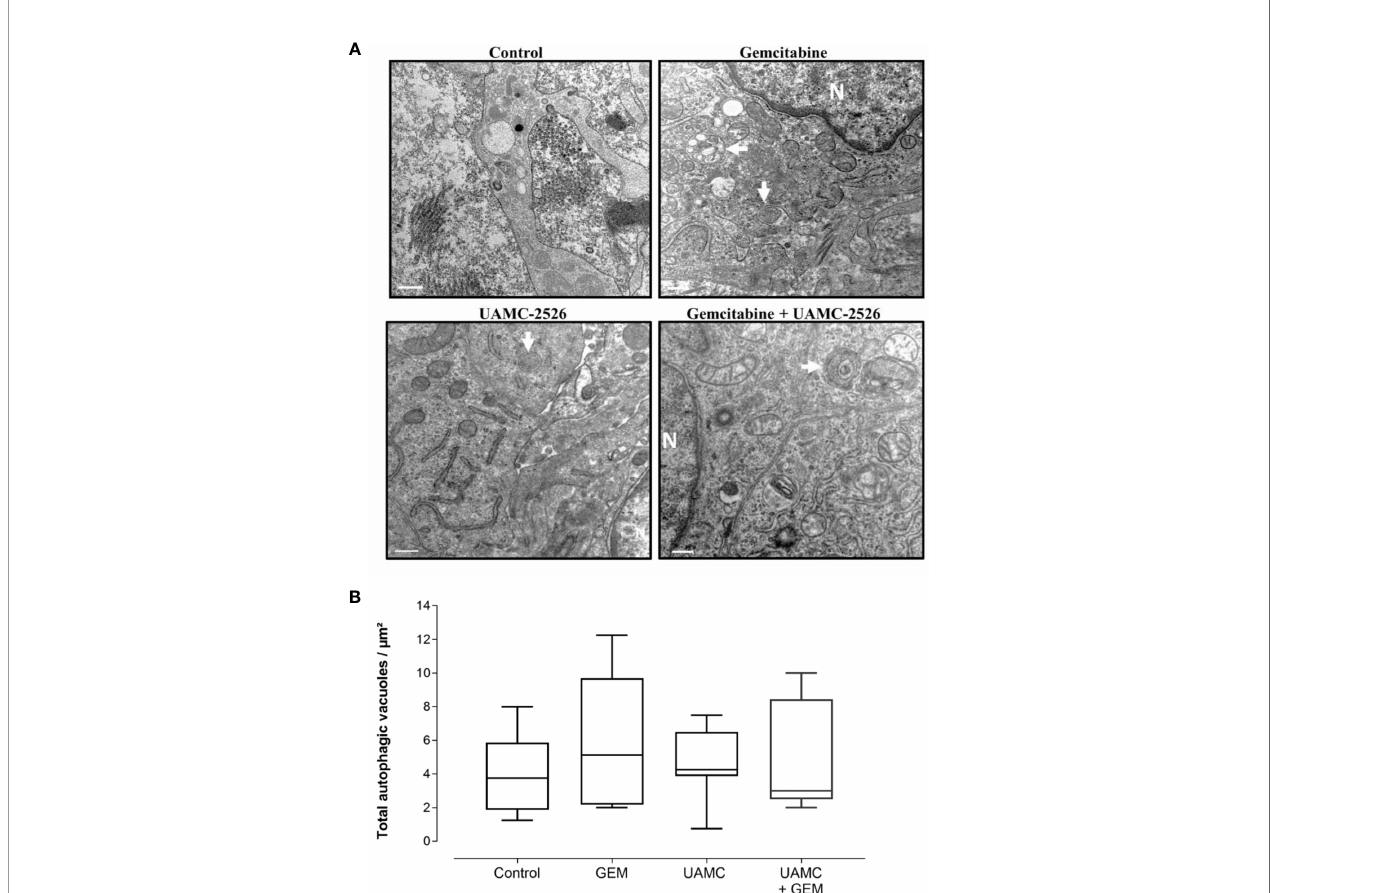
FIGURE 11 | Detection of autophagy in Panc02 tumors via transmission electron microscopy. (A) C57/BL6 mice with Panc02 tumors were treated with vehicle (control), UAMC-2526 (UAMC), gemcitabine (GEM) or a combination of UAMC-2526 and gemcitabine. After treatment, ultrathin sections of Panc02 tumors were analyzed for the presence of autophagic vacuoles (white arrows) using transmission electron microscopy. Representative images are shown, Scale bar = 500 nm. N = nucleus. (B) Quanti fi cation of autophagic vacuoles. Number of animals in each group was between 8-10. One-way ANOVA test showed no signi fi